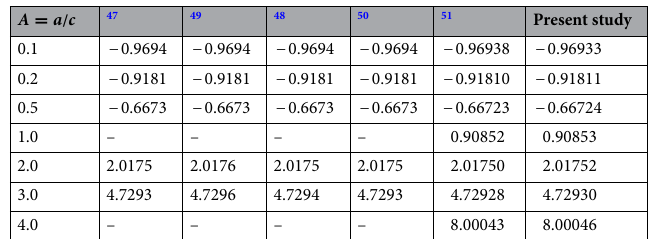
Table 4. Comparison of outcomes with Mahapatra and Gupta 47 , Ishak et al. 48 , Nazar et al. 49 , Ali et al. 50 , and Gireesha et al. 51 for co-efficient Skin friction f ′′ ( 0 ) considering β = n = d = W e = 0 by varying A = a / c